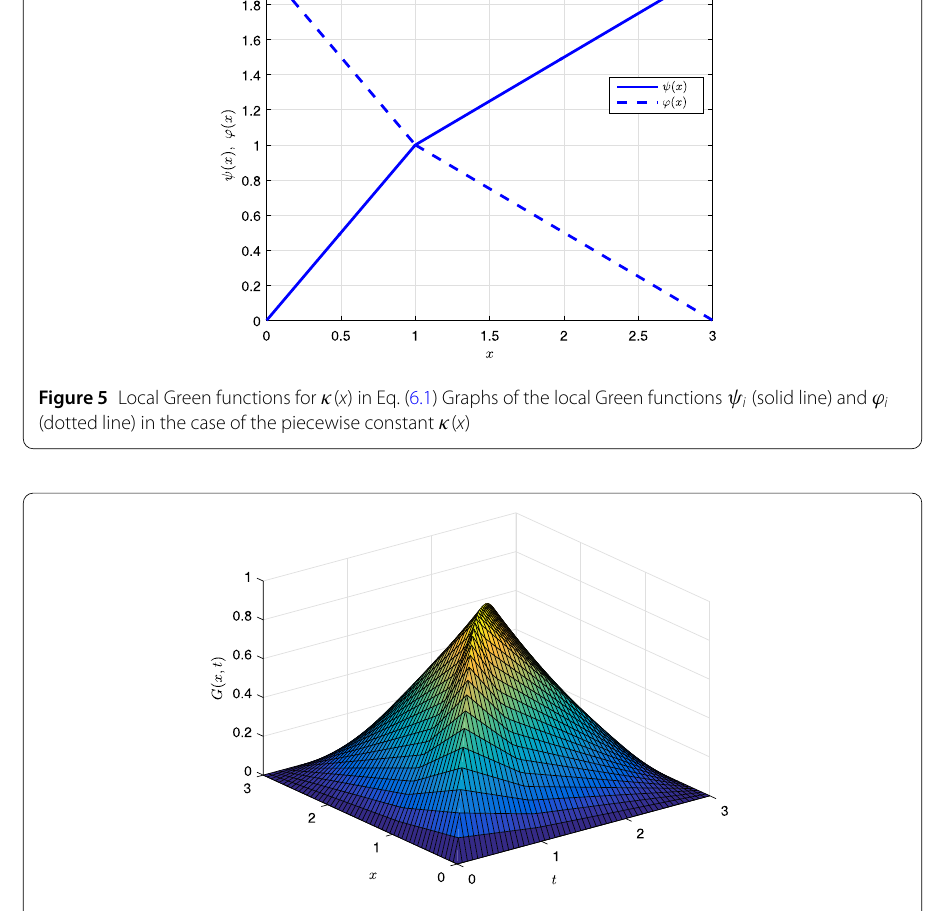
Figure 6 Green function for κ ( x ) in Eq. (6.1) Graph of the Green function G ( x , t ) for the piecewise constant κ ( x